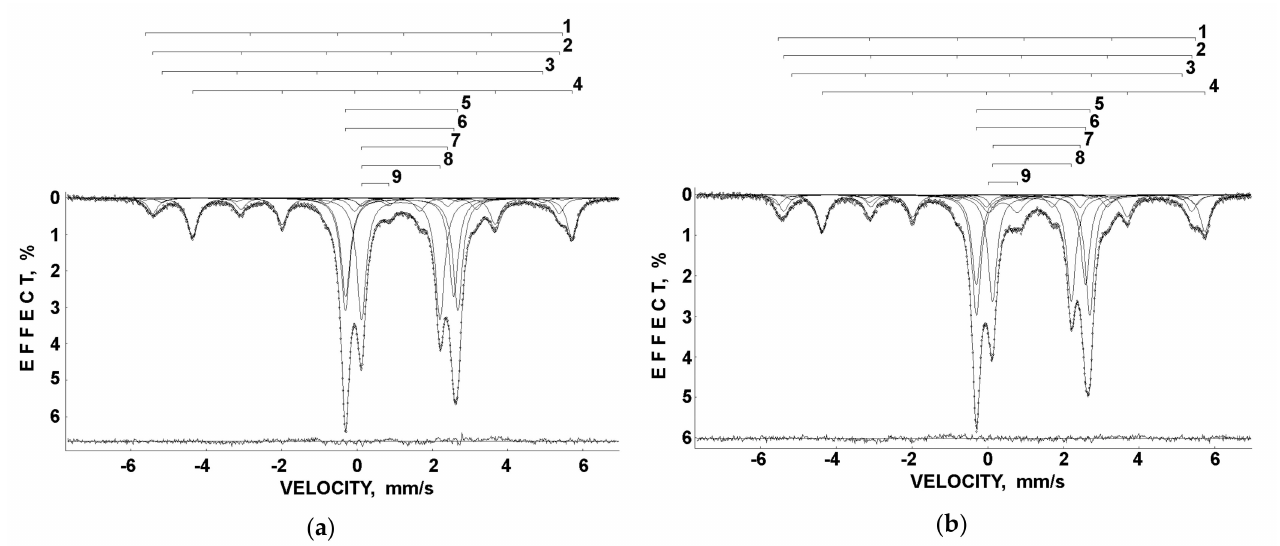
Figure 17. Room temperature Mössbauer spectra of equilibrated ordinary chondrites Ochansk H4 ( a ) and Vengerovo H5 ( b ). Spectral components are explained in the text. The differential spectra are shown on the bottom. Adapted from References